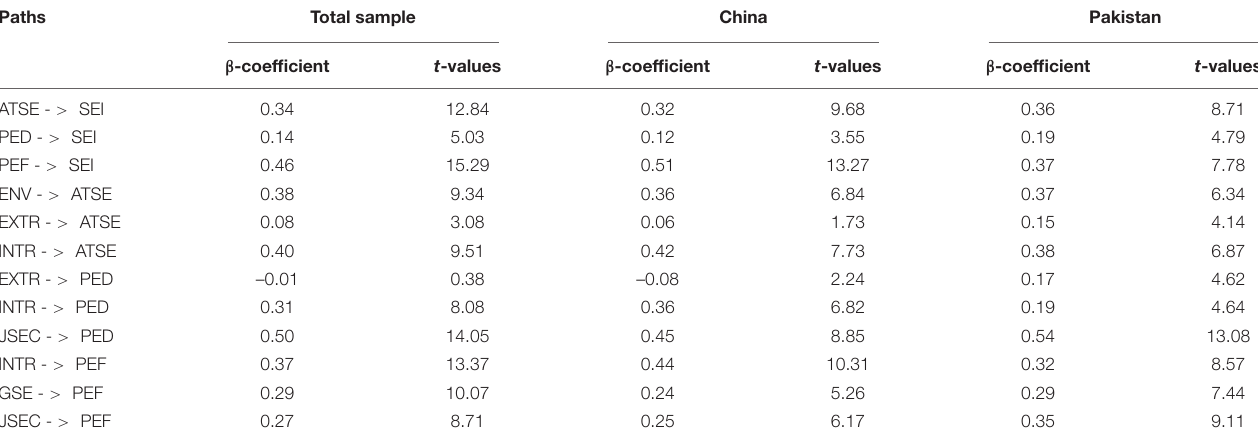
TABLE 7 | Outcomes of direct effects of path coefficients among the constructs. Paths Total